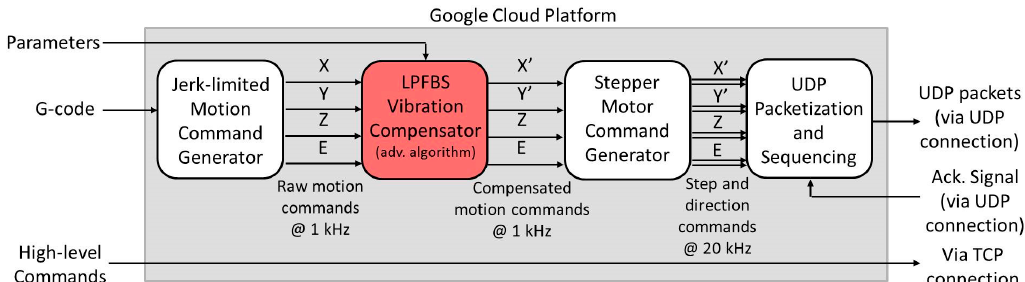
Figure 3. Block diagram of algorithms contained in cloud-based controller running on the Google Cloud Platform. Note that the 1 and 20 kHz frequencies are not real-time execution rates, they represent the sampling frequencies of the output signals. The algorithm highlighted in red is a computationally intensive advanced algorithm for vibration compensation.